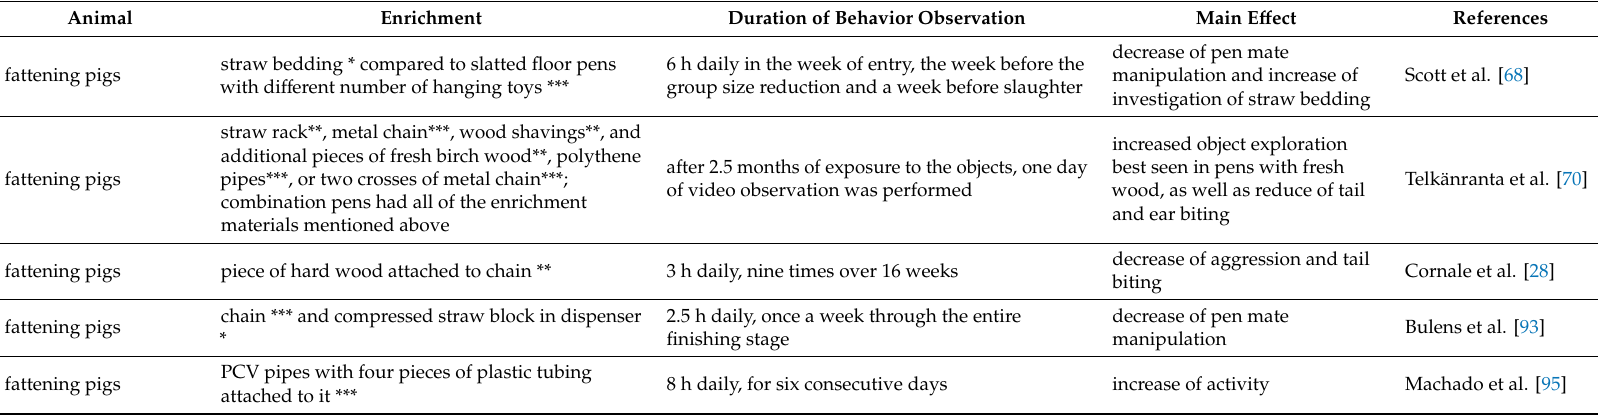
Table 2. Environmental enrichment materials and objects according to the categories included in the Commission Recommendation (EU) 2016 / 336, and their main e ff ects on fattening pig